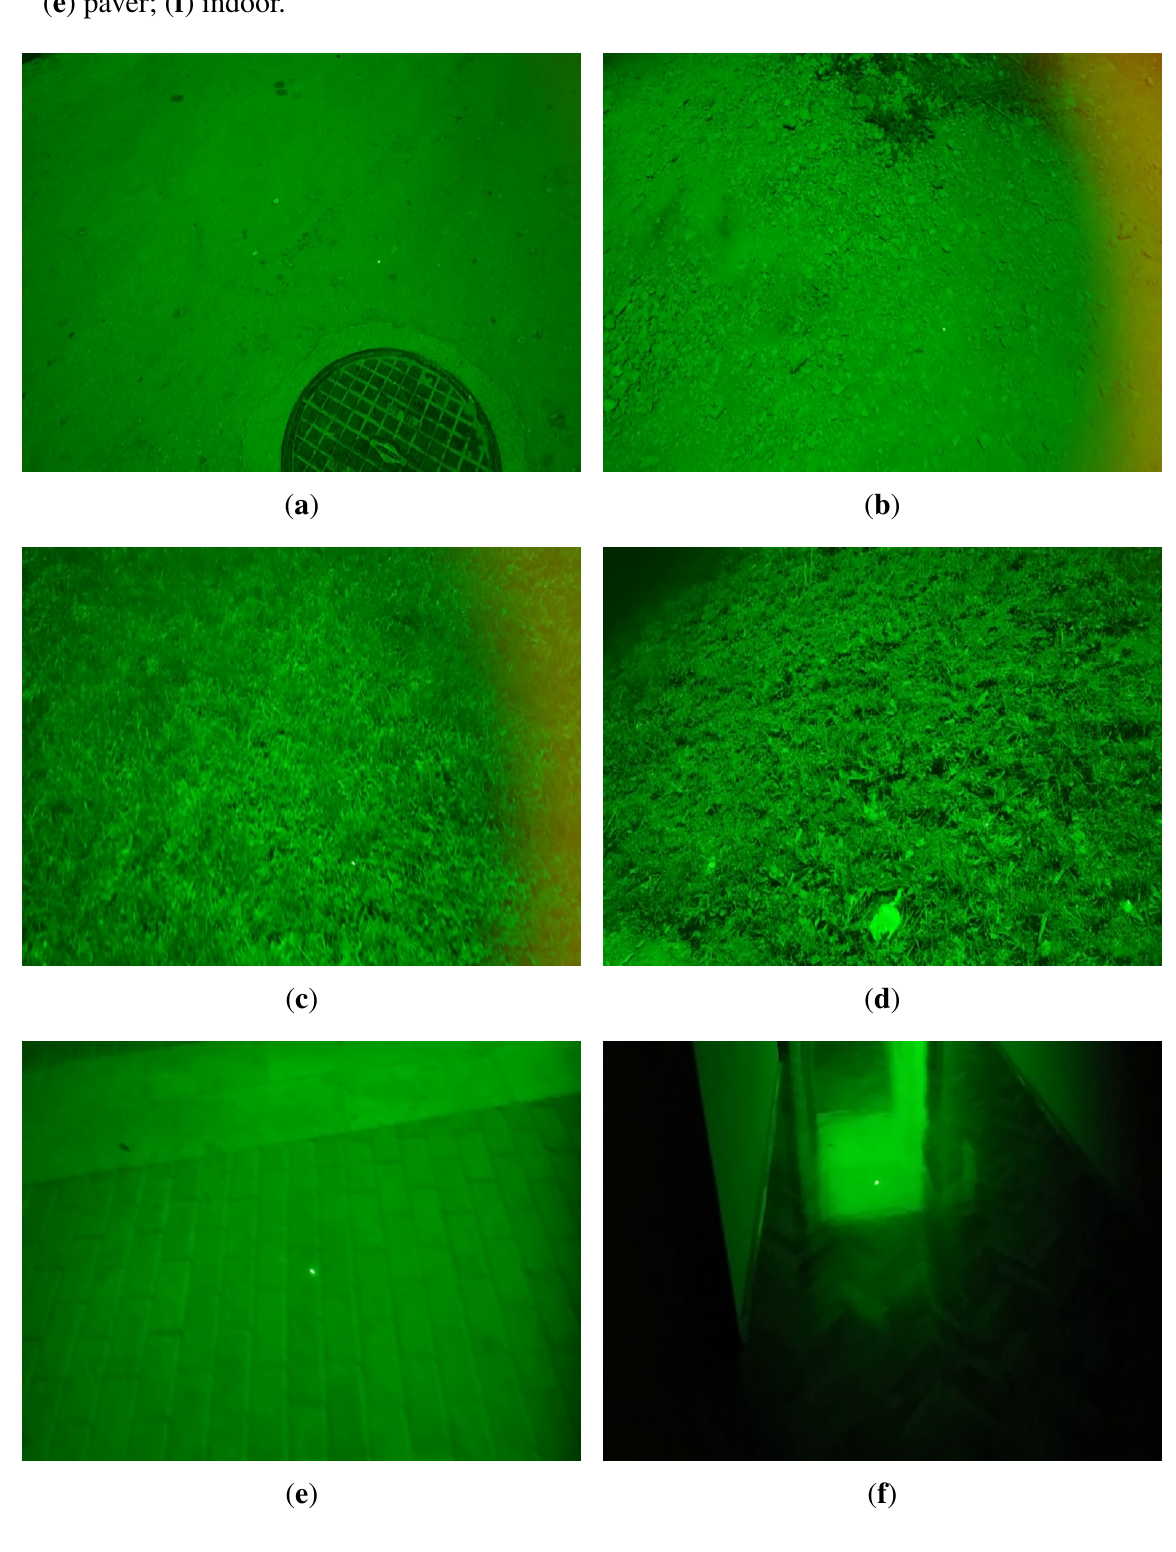
Figure 5. Examples of different backgrounds. ( a ) street; ( b ) dirt; ( c ) fairway; ( d ) grass; ( e ) paver; ( f )